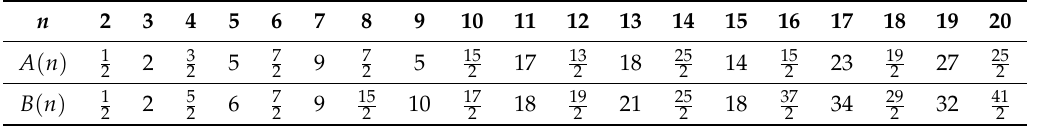
Figure 4. U ( 5 ) and ϕ ( 5 ) . Table 3. Values of A ( n ) and B ( n ) ( 2 ≤ n ≤ 20 )